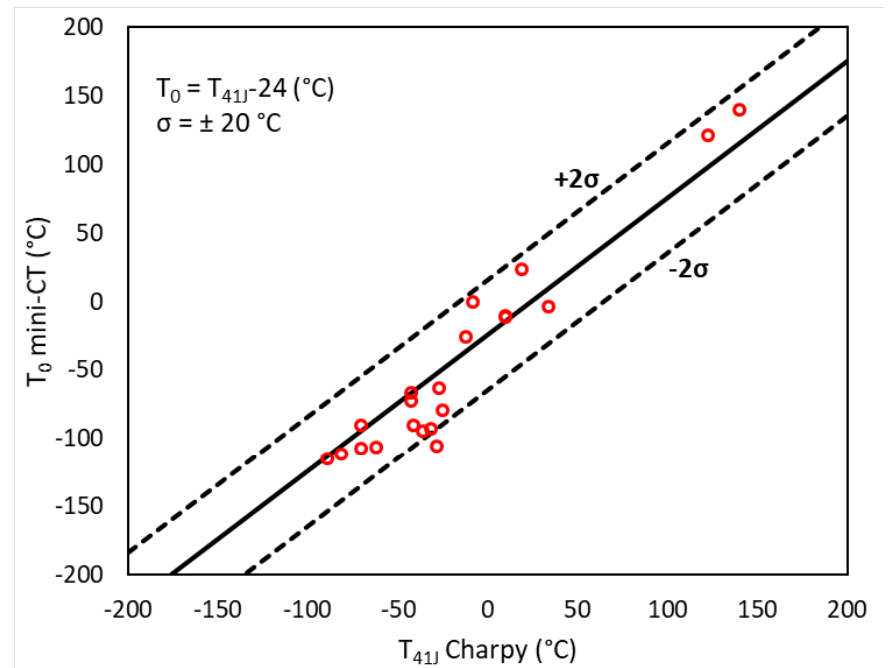
Figure 4. Correlation between mini-CT T 0 values and T 41J values obtained from Charpy testing. Data were taken from [7,8,11,14,22,23,30,33,35,37,38]. Table 1. Influence of error in initial T 0 guess on the success rate of valid T 0 evaluation with N=12 or fewer specimens [36].